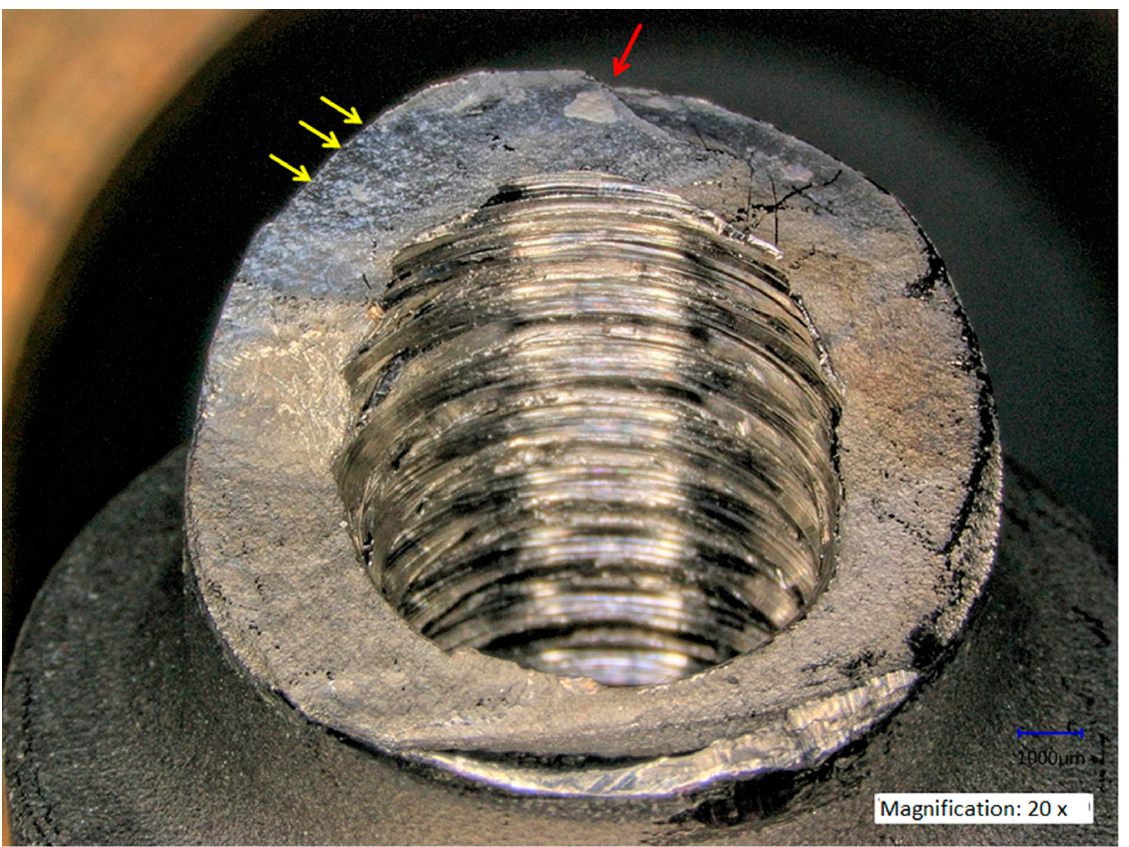
Figure 5. Broken taper with screw thread for extraction-lateral initiation of the crack with progression in medial direction (red arrow in the region with bright deposits marks the area of crack initiation; occurring rest lines are marked with yellow arrows).